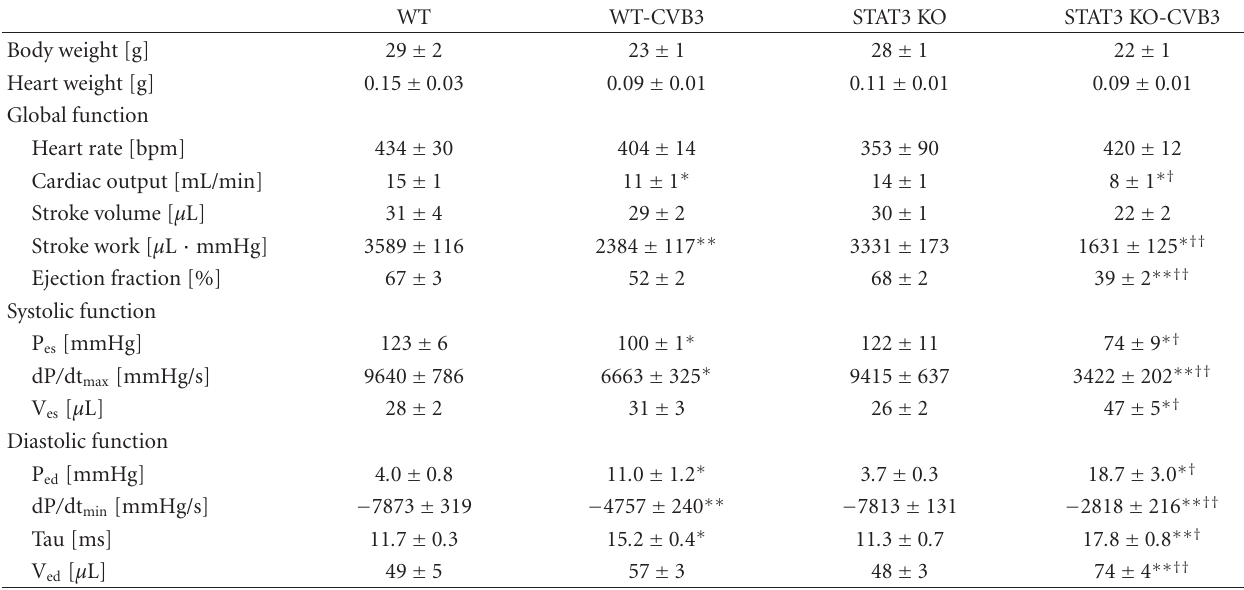
Table 1: Animal characteristics and hemodynamic measurements 28 days after CVB3